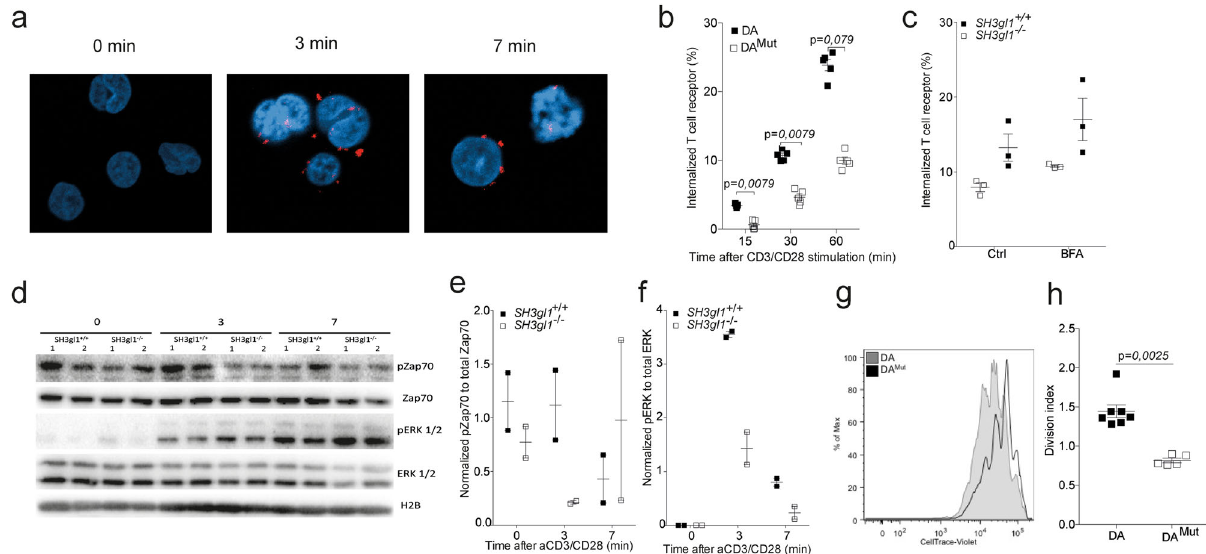
Fig. 4 Endophilin A2 co-localizes with the TCR upon activation and regulates TCR internalization and signaling. a EA2 co-localization with the TCR in Jurkat cells after anti-CD3/CD28 stimulation determined by proximity-ligase assay and visualized as TexasRed + spots using confocal imaging. b Percentage of internalized TCR in T cells from 5 DA and 5 DA Mut rats after anti-CD3/CD28 stimulation. Data has been reproduced two times. c Percentage of internalized TCR in CD4 + CD3 + T cells from three SH3gl1 − / − and SH3gl1 + / + mice stimulated with anti-CD3/CD28 for 30 min in the presence or absence of Brefeldin A at 1.25 μ g/ml. Experiment has been repeated twice with the same results. d Representative Western blot analysis from two experiments of phosphorylated and unphosphorylated ZAP70 and ERK1/2 in T cells from two SH3gl1 − / − and SH3gl1 + / + mice stimulated with anti- CD3/CD28 for 0, 3, and 7 min. Histone 2B was used as loading control. e Normalized OD values of phosphorylated Zap70 compared to unphosphorylated Zap70 from two SH3gl1 − / − and SH3gl1 + / + mice. f Normalized OD values of phosphorylated ERK1/2 compared to unphosphorylated ERK1/2 from two SH3gl1 − / − and SH3gl1 + / + mice. g Flow cytometry blot showing in vitro cell proliferation of DA Mut and DA T cells 72 h after anti-CD3/CD28 stimulation. h Division index of sorted T cells from 7 DA and 5 DA Mut rats after 72 h of anti-CD3/CD28 stimulation. Non-parametrical Mann – Whitney U test was used for statistical evaluation of data. Data are presented as mean with error bars indicating ± SEM with each dot representing an individual